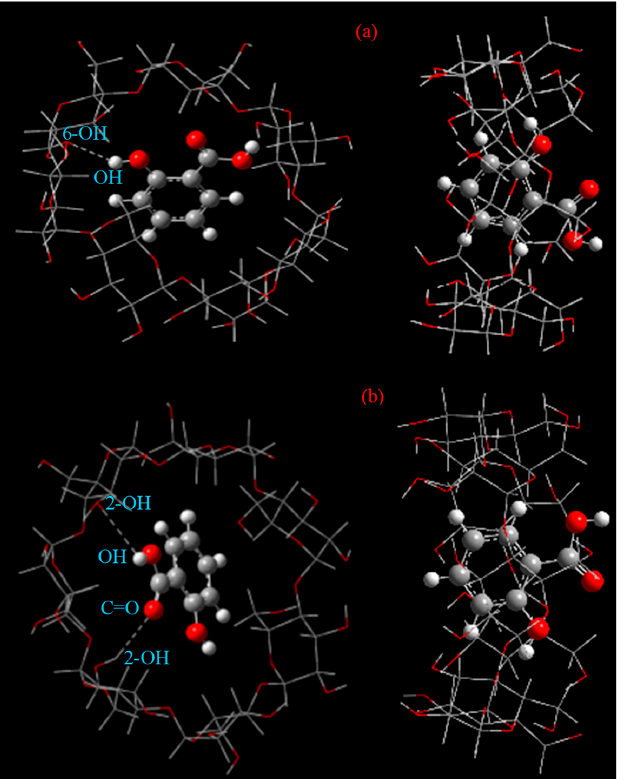
Figure 8. The structures of SA/ β -CD with minimum energy achieved by ONIOM calculation: ( a ) passing process with head up and ( b ) with head down. Dotted lines are the H-bonds between SA and β -CD. Table 5. Type, bond length (R), and bond angle (A) obtained by ONIOM (B3LYP/6-31G: PM3).